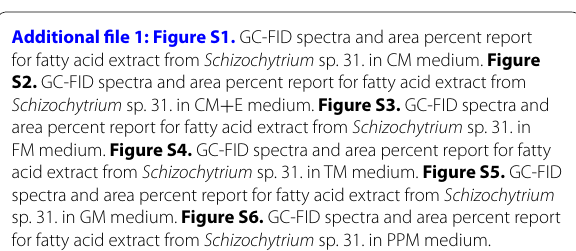
CM complex medium, FM fructose medium, TM tryptone medium, GM glycerol medium, PPM proteose peptone